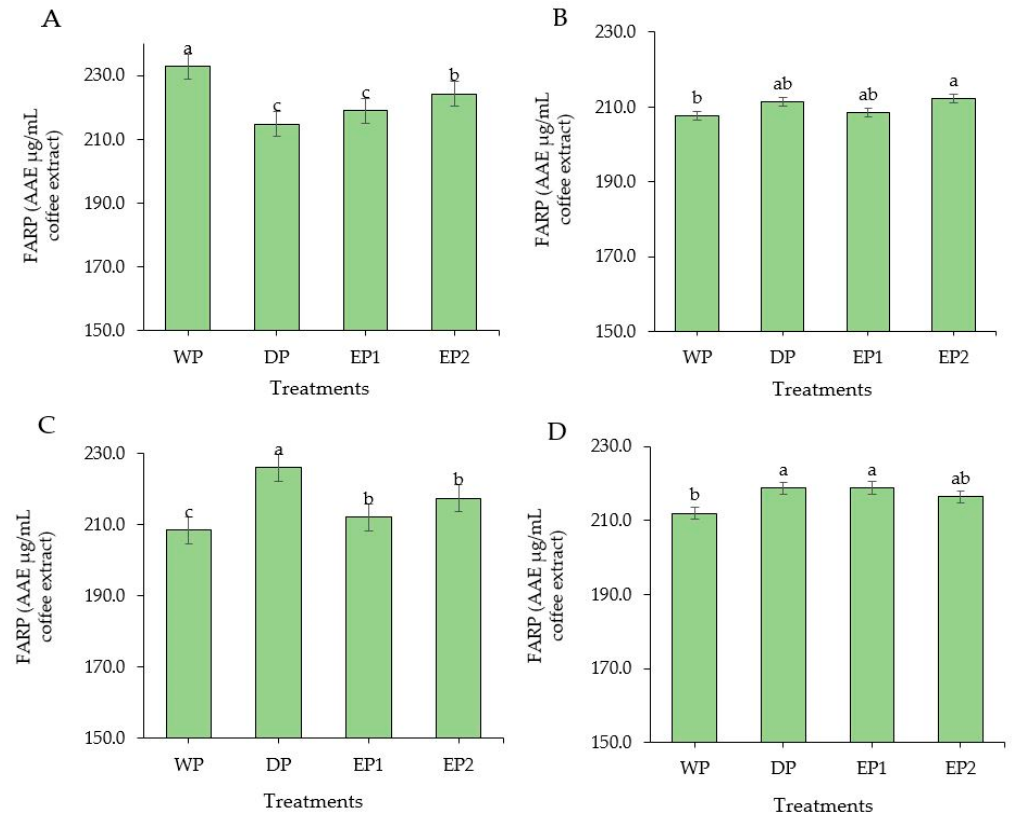
Figure 3. Ferric-reducing antioxidant power (FRAP) of green and roasted coffee beans that were processed with different methods. ( A : Green beans; B : Light roasted, C : Medium roasted; D : Dark roasted). EP1: elephant dung coffee (pulp was completely digested); EP2: elephant dung coffee (pulp was not digested); WP: wet-processed beans; DP: dry-processed beans. Different letters above the bars indicate statistically significant difference at p < 0.05.